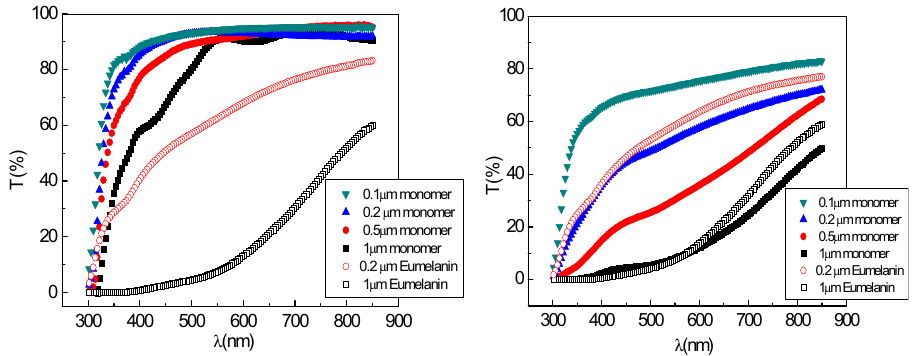
Figure 1. Transmittance spectrum of DHI films soon after deposition (left, t = 0) and after aging (right, t = 4 weeks). For comparison, the transmittance spectra of two separate eumelanin thin films (0.2 μ m and 1 μ m) prepared by the AISSP procedure are also reported in each graph. The absorption profiles are reported in Figure